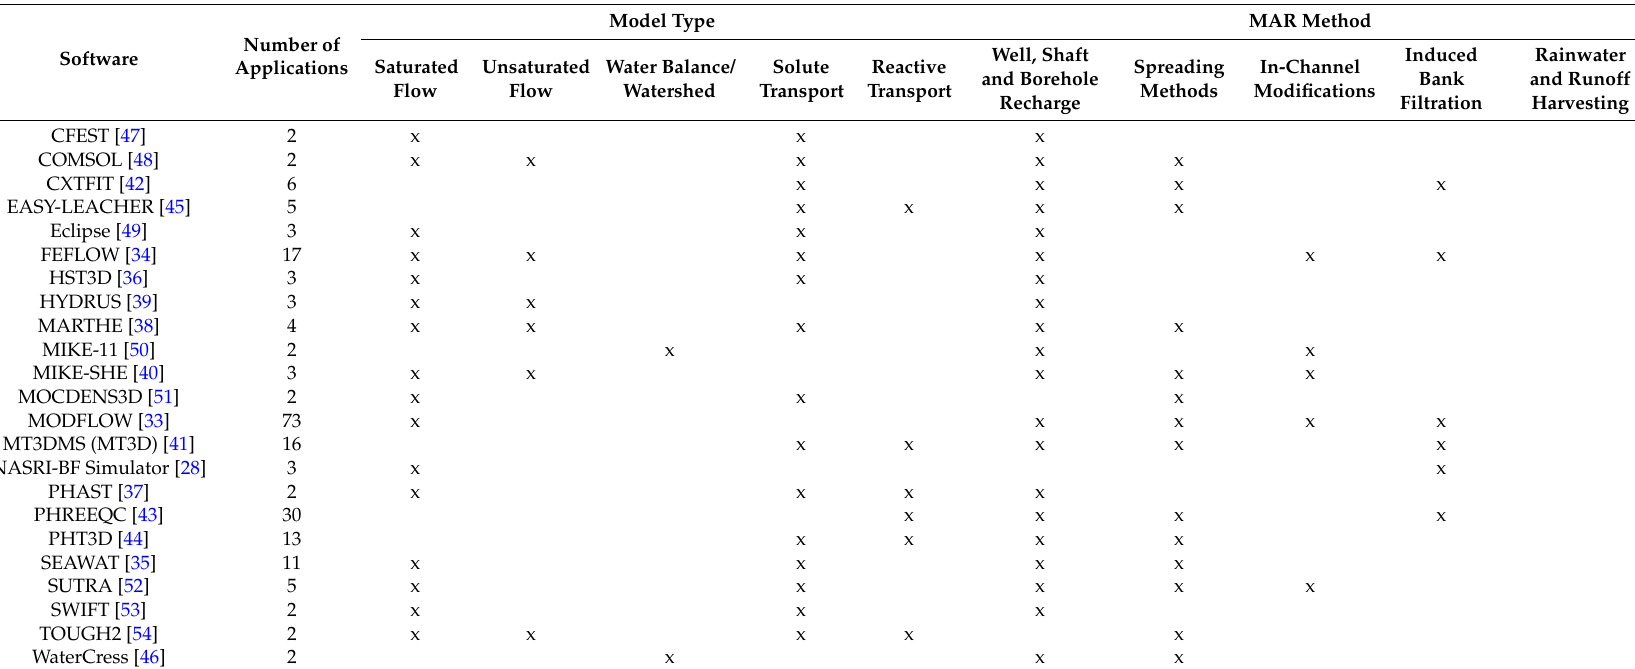
Table 2. List of modeling software tools which were applied more than once in literature studies arranged in alphabetical order including the number of applications. The main MAR methods analyzed and the model types covered by the listed software tools are marked with “x” (note that some software tools can also be feasible for other MAR methods and might be applicable to further model